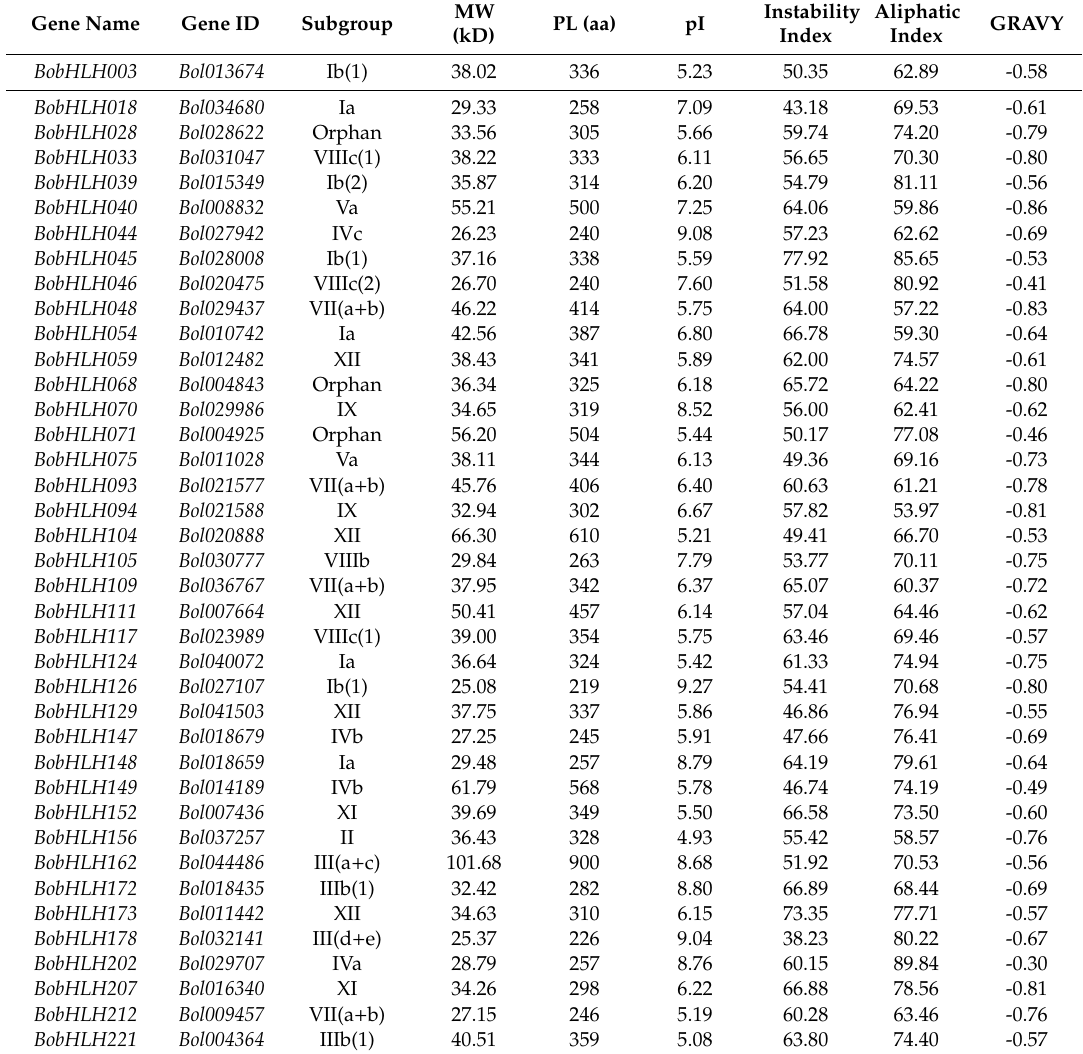
Table 1. Chilling-responsive BobHLH genes in B. oleracea